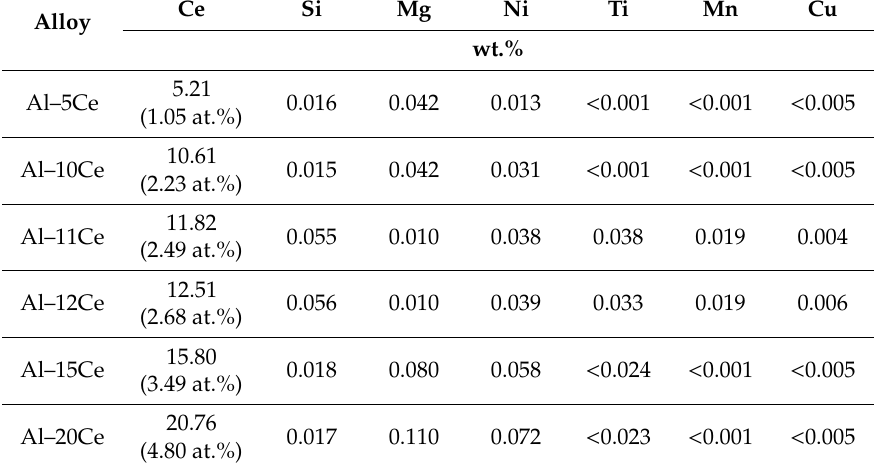
Table 2. Chemical compositions of the Al–Ce binary alloys investigated in this study, measured by OES / ICP